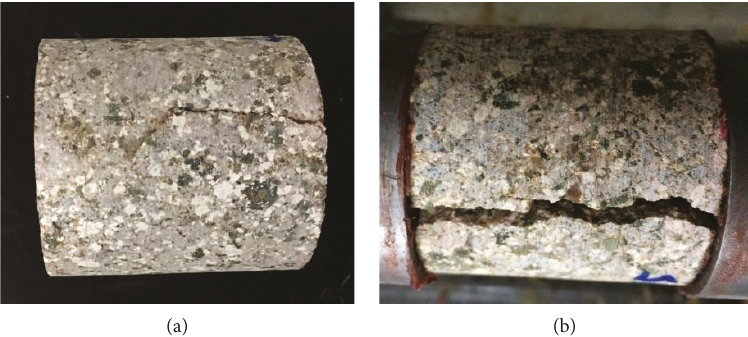
Figure 6: Single impact loading specimen failure mode: (a) M4 ( v = 7 m/s) and (b) M5 ( v =8 m/s).